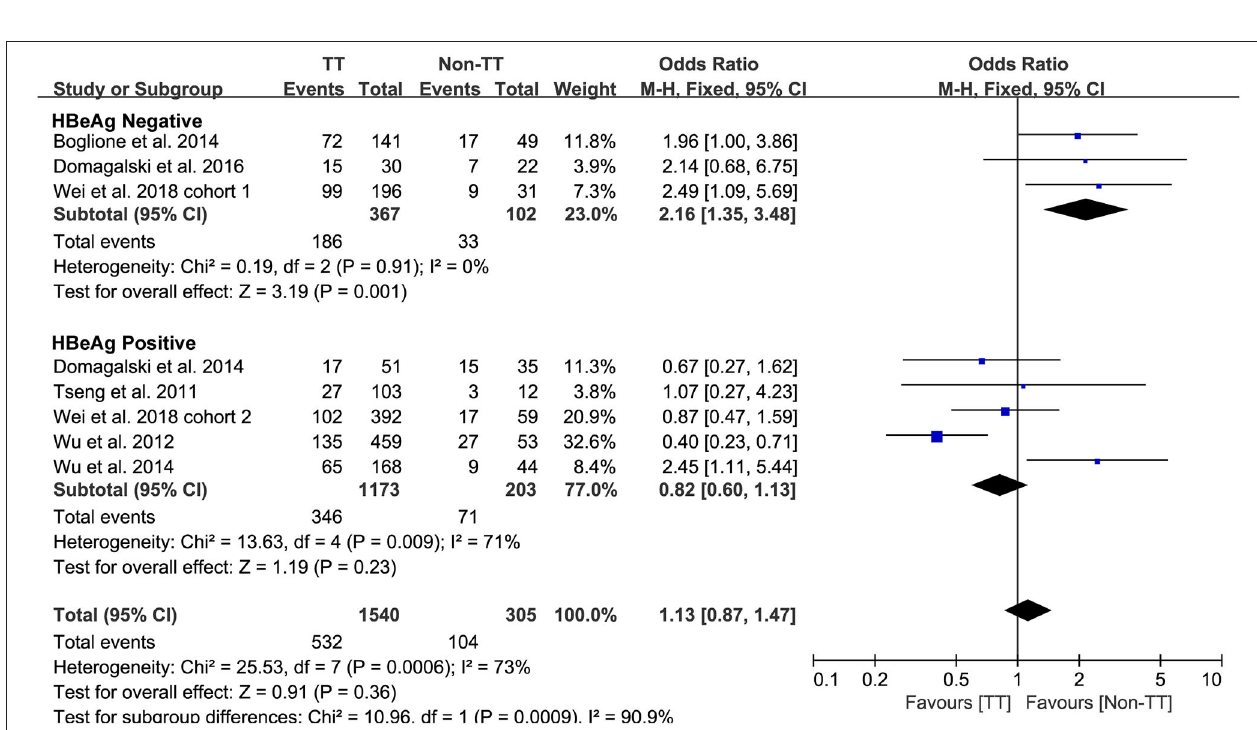
Frontiers in Medicine |